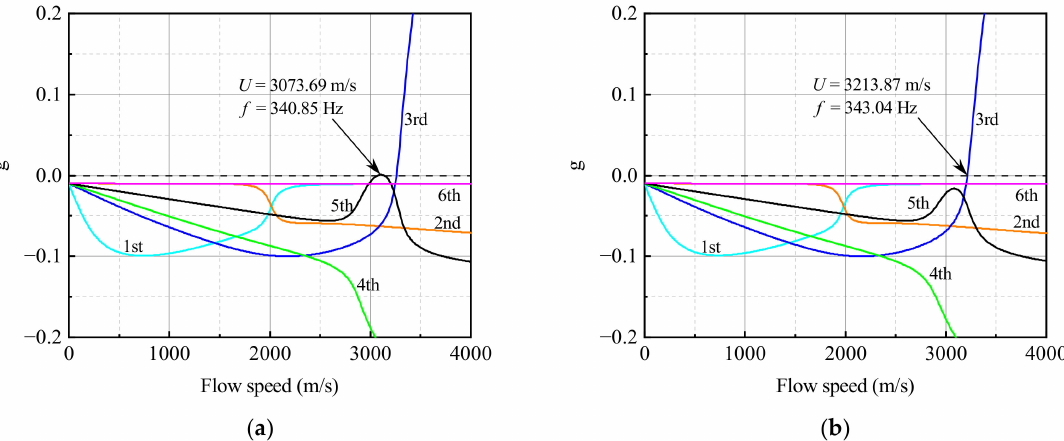
Figure 12. Change of the unstable mode under different sweep angles. ( a ) Sweep angle is 57 deg. ( b ) Sweep angle is 58